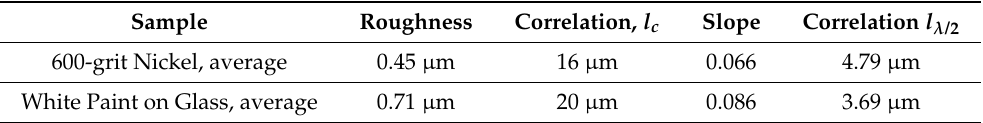
White Paint on Glass,